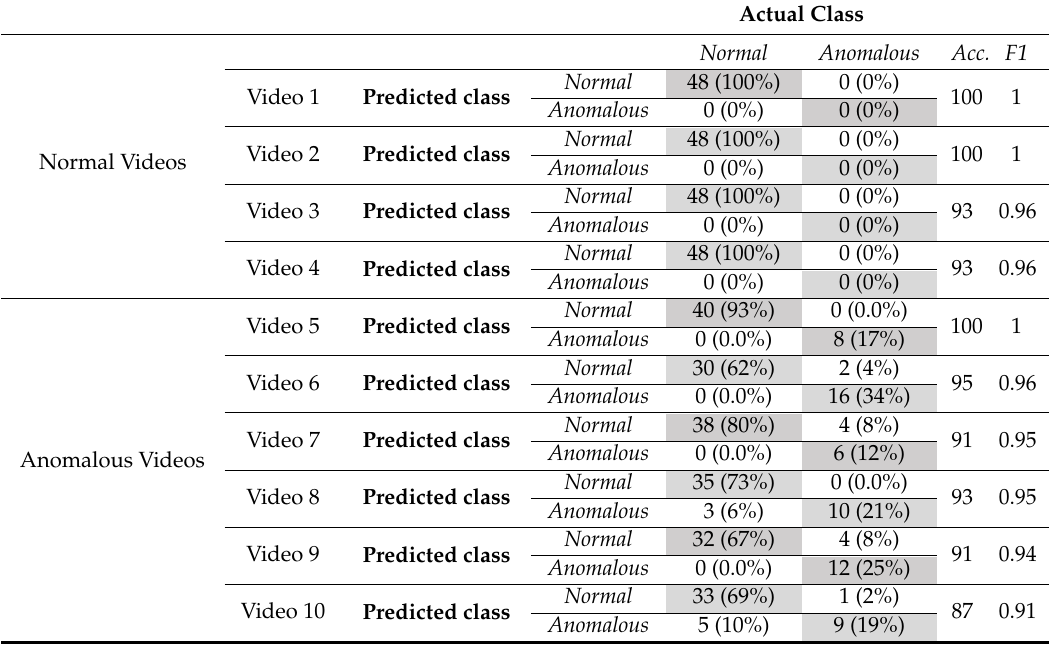
Table 5. Actual class, predicted class and accuracy (acc. in percentage) of the classification for test videos, proposed particle filter. In this table, Normal represents a region (block) without leakage (positive) and Anomalous represents a region (block) with leakage (negative). Shading is to di ff erentiate the